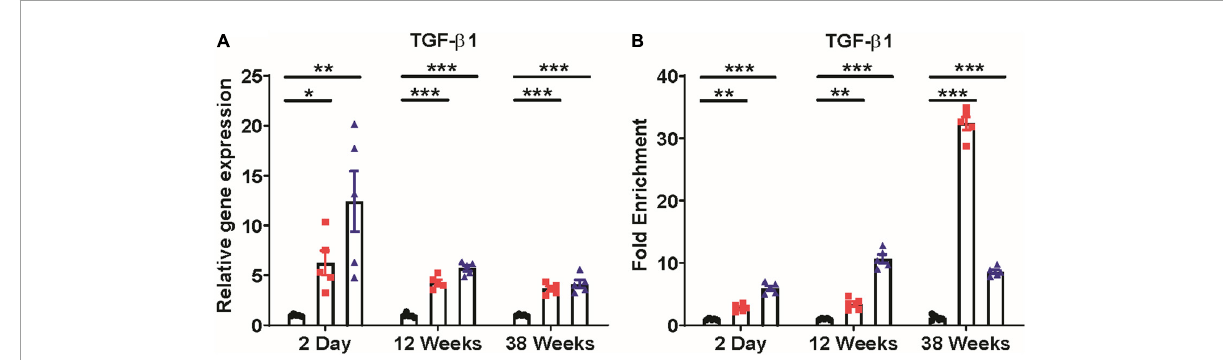
FIGURE12 Expression of TGF- β 1 and DNA methylation alterations in TGF- β 1 gene-body. Prenatal As exposure induces TGF- β 1 expression in the kidney (A) . Change in TGF- β 1 gene-body methylation in exposed progeny was studied through methylated DNA immunoprecipitation (MEDIP) assay. Hypermethylation of the TGF- β 1 gene-body was shown and represented as fold enrichment over controls (B) . The data represent the mean ± SEM, n = 5 (number of experimental sets). * p < 0.05, ** p < 0.001, and *** p <